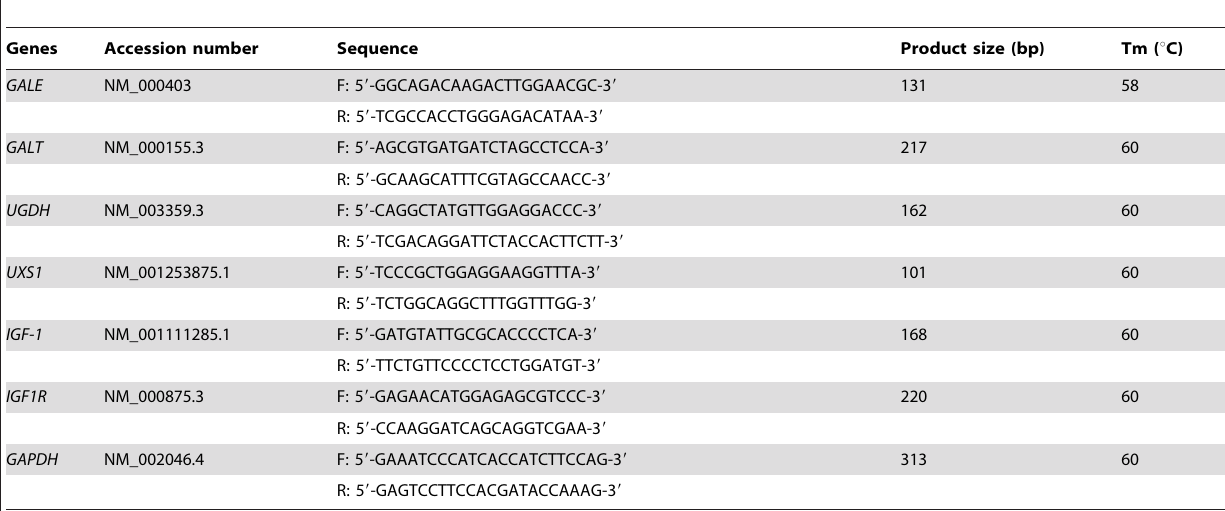
Table 1. Primer sequences and the optimal PCR